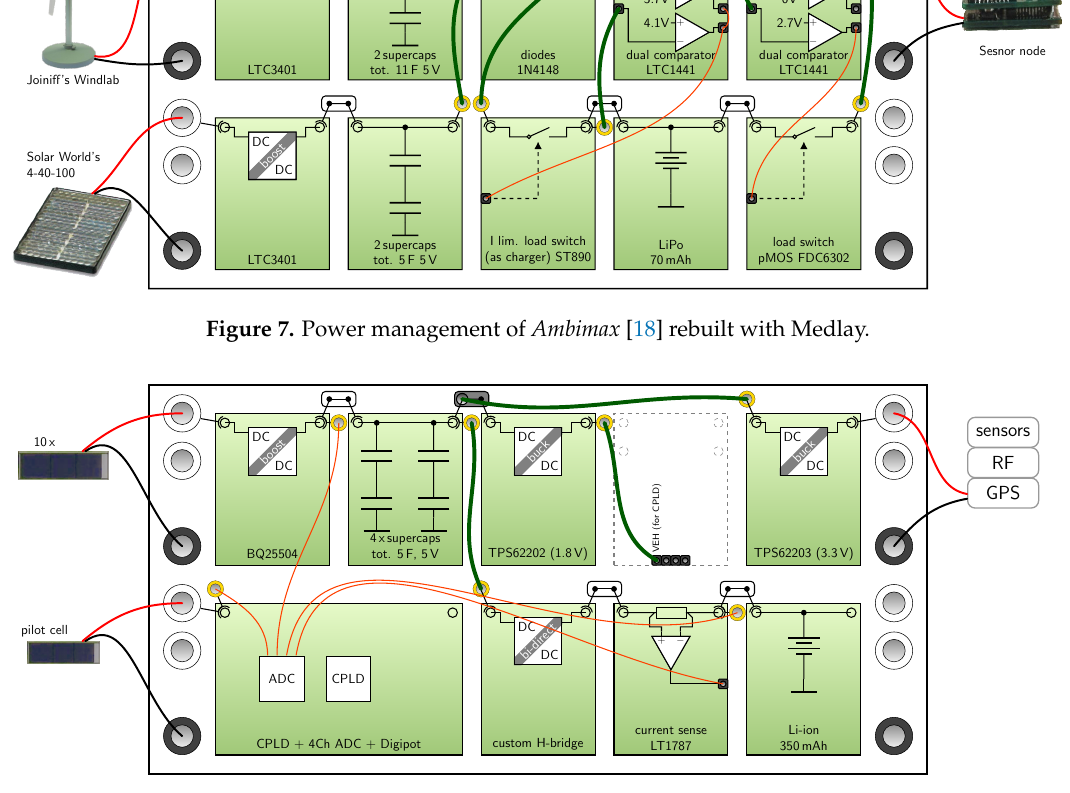
Figure 8. Power management of Trio [19] rebuilt with Medlay.